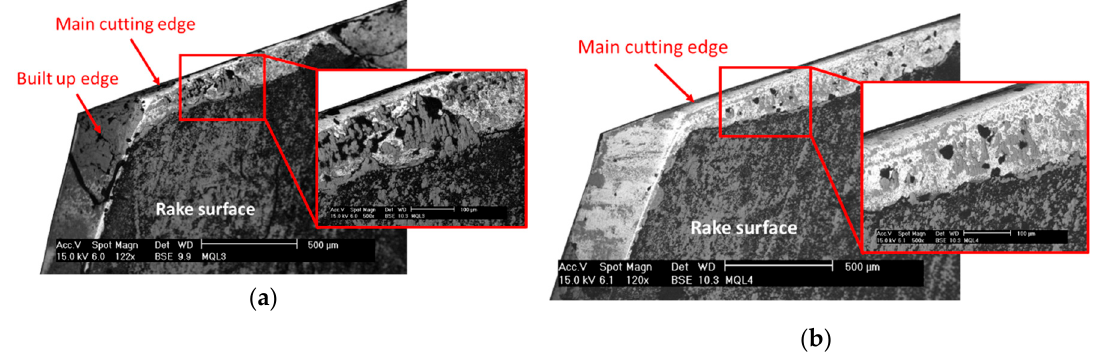
Figure 6. Composition analysis of the rake surface, after 40 holes, in a Ti/CFRP/Ti coupon. The black color corresponds to the carbon components, the grey tones are titanium alloy, and the white indicates the tungsten of the carbide substrate. ( a ) A 3 mL/h lubrication level. ( b ) A 15 mL/h lubrication level.